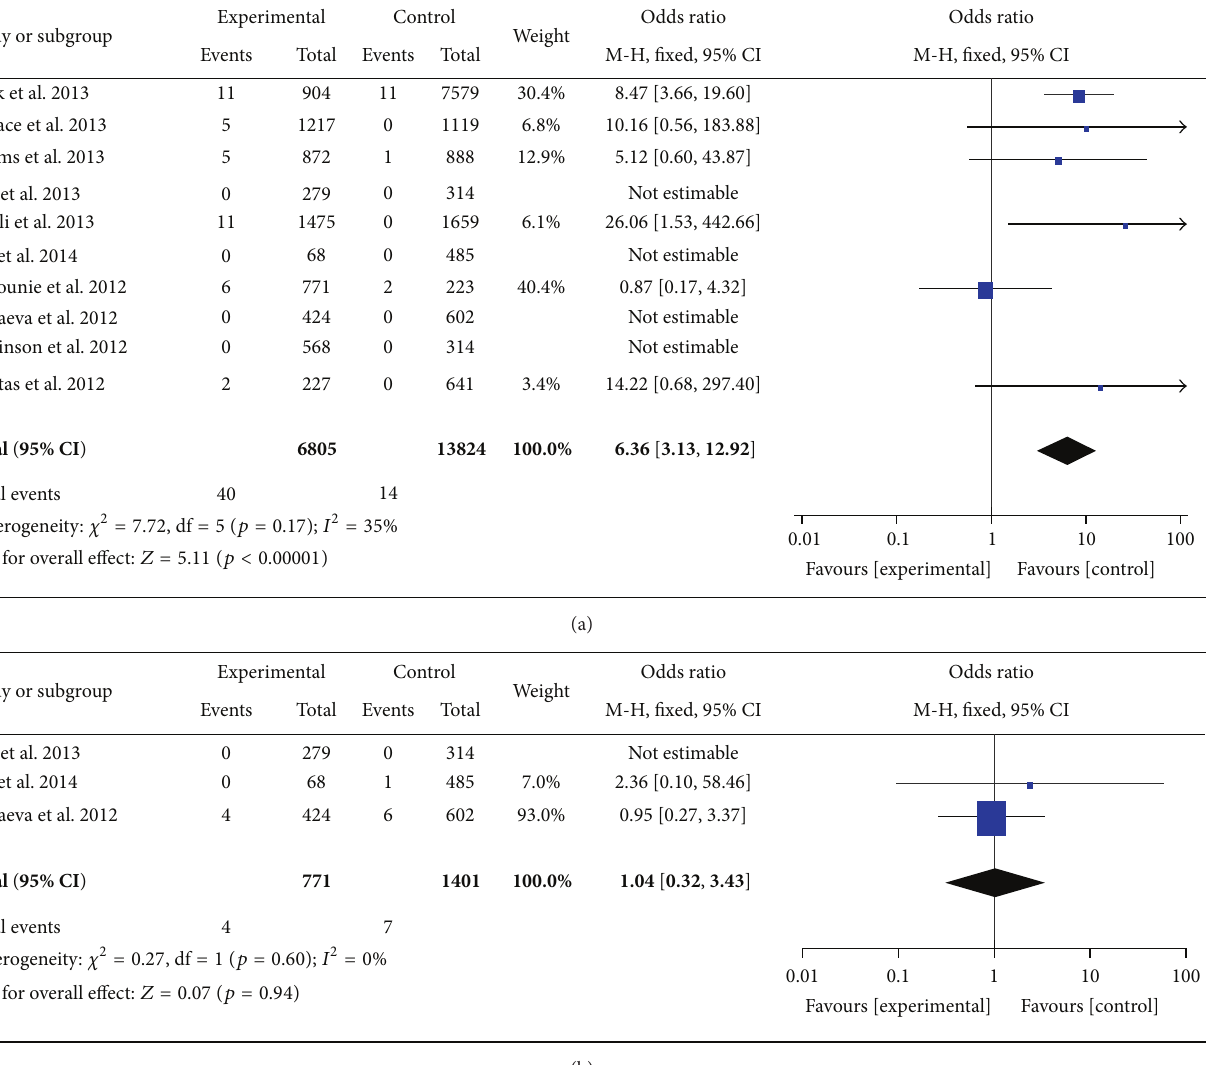
Figure 1: (a) Forest plot of the association between C9orf72 repeat expansions and AD. (b) Forest plot of the association between C9orf72 intermediate repeat copies and